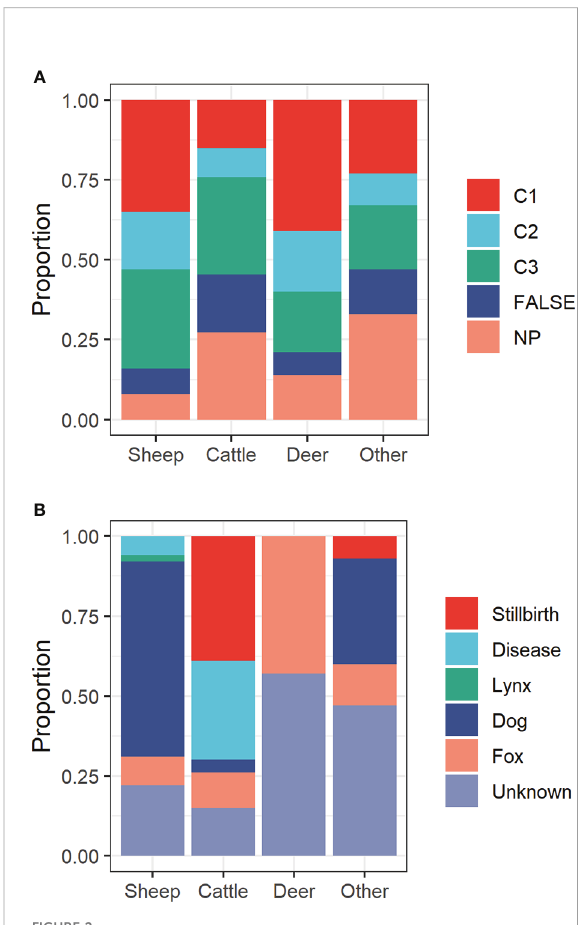
FIGURE 2 (A) Proportion of reported predation events on livestock by wolves in Brandenburg state (Germany), strati fi ed by monitoring category (C1: clear evidence; C2: con fi rmed hint; C3: uncon fi rmed hint; FALSE: livestock loss not caused by wolves; NP: evaluation not possible) and livestock category. (B) Proportion of livestock causes for livestock losses from the FALSE-subset (where wolves were excluded as possible mortality